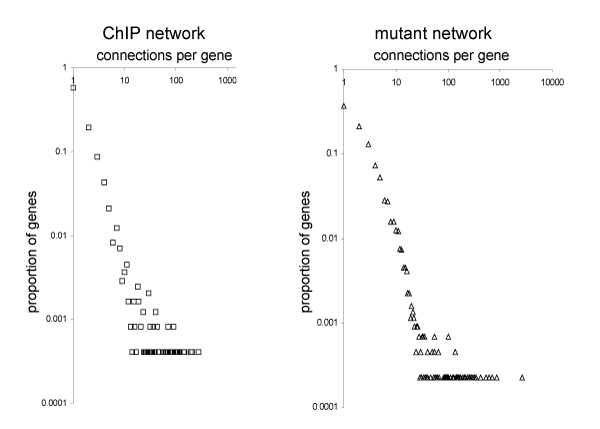
Log-log plot of the node connectivity in different topological networks. The genes with the highest degrees are ABF1 in the ChIP-network and TUP1 in the mutant network, adapted from [2]